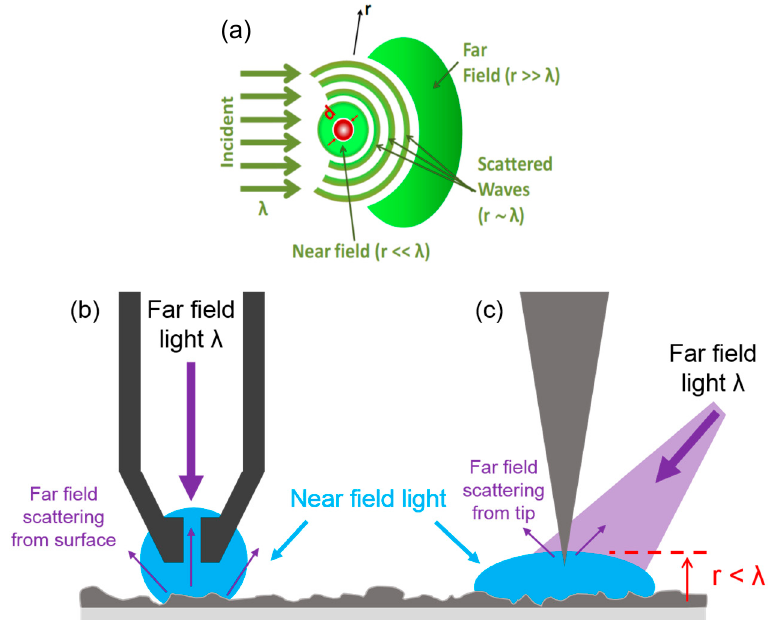
Figure 1. The near-field and types of SNOM tips. ( a ) The far and near-field microscopy arrangements are defined by the proximity of the probe to the nano object being probed. When at a distance ( r ) from the emitting object that is much less than the wavelength of light used, evanescent light dominates the light field; ( b ) Aperture SNOM where an evanescent light field created by a nanoscale opening at the end of a tip is scattered off of the surface. Light scattered from the surface is detected in the far-field; ( c ) Apertureless SNOM utilizes near-field light emitted from the surface due to external illumination that is scattered off of a sharp tip into the far-field to be detected.